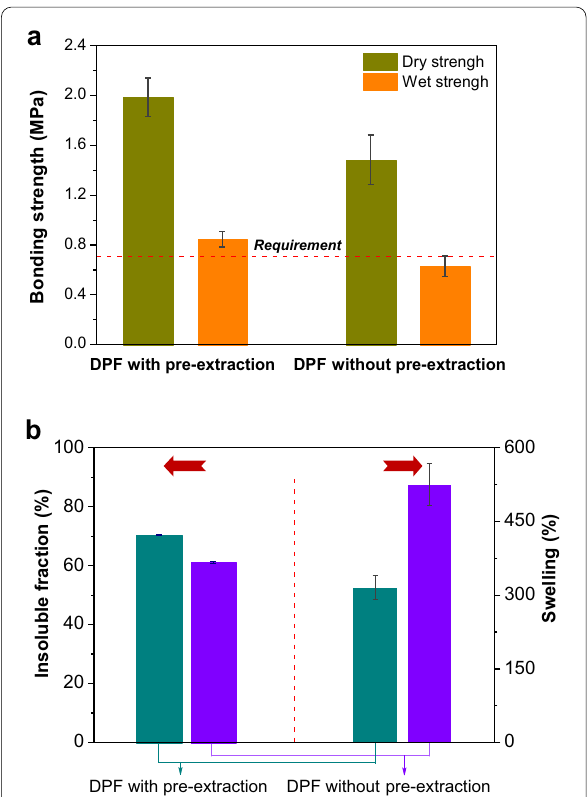
Fig. 7 a The dry and wet bonding strength of plywoods using DPF as adhesives with and without PP pre-extraction; b the insoluble fraction and swelling of DPF-based adhesives with and without PP